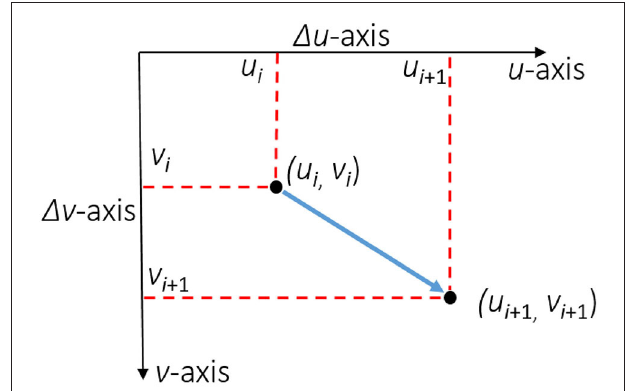
FIGURE 5 | Here we depict where movements in 2D image space. u and v represent coordinates in the image space at a specific prior time point (e.g., before movement), and i is the frame index in the image flow. u and v are image-based coordinate representations of vector spaces, represented by 1 u − axis and 1 v − axis . Each successive point is represented by P i + 1 = ( u i + 1 , v i + 1 )